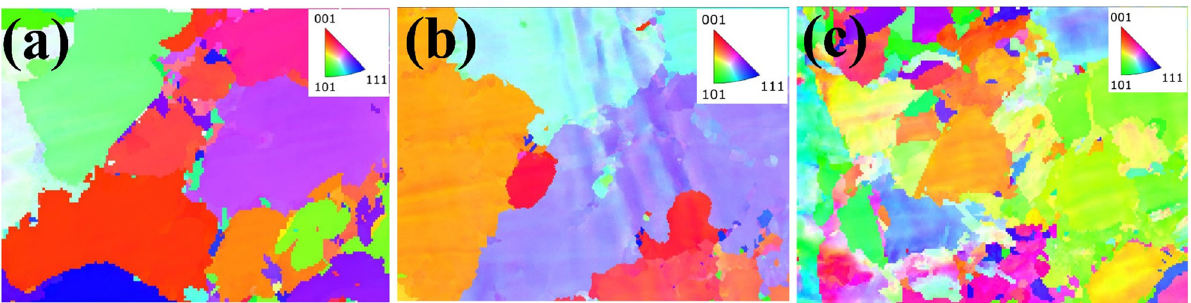
Figure 7: IPF diagrams for Ag ( s.s ) and Cu ( s.s ) in the brazing seam. ( a ) 0%; ( b ) 2%; and ( c ) 3%.